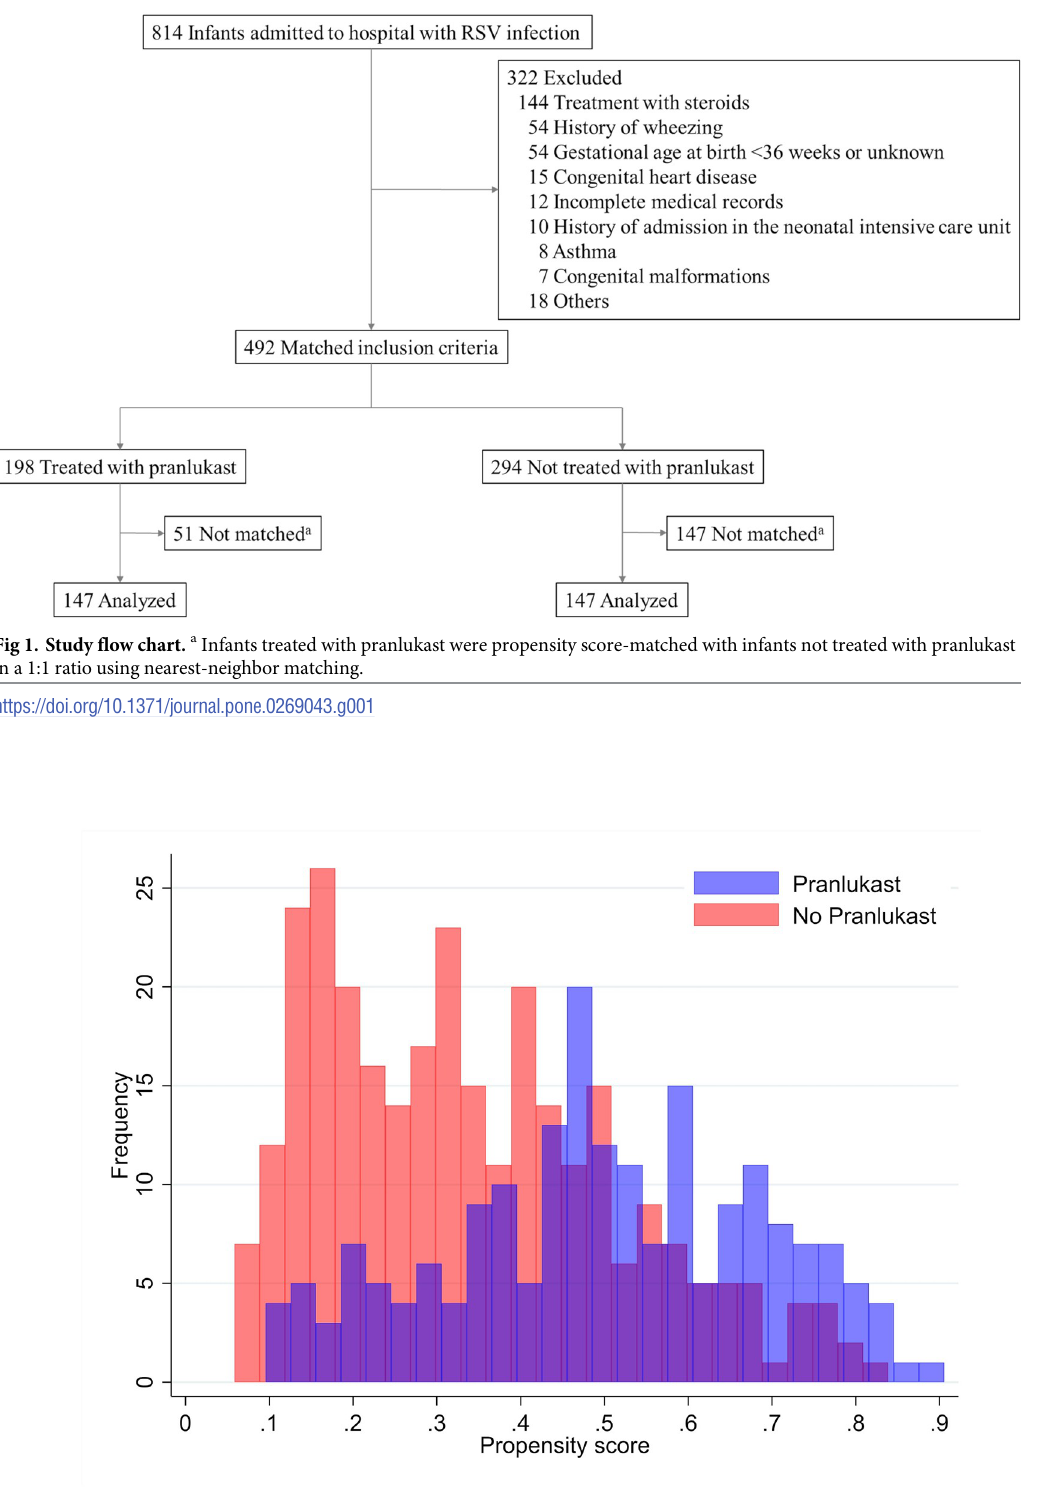
PLOS ONE | https://doi.org/10.1371/journal.pone.0269043 May 27,